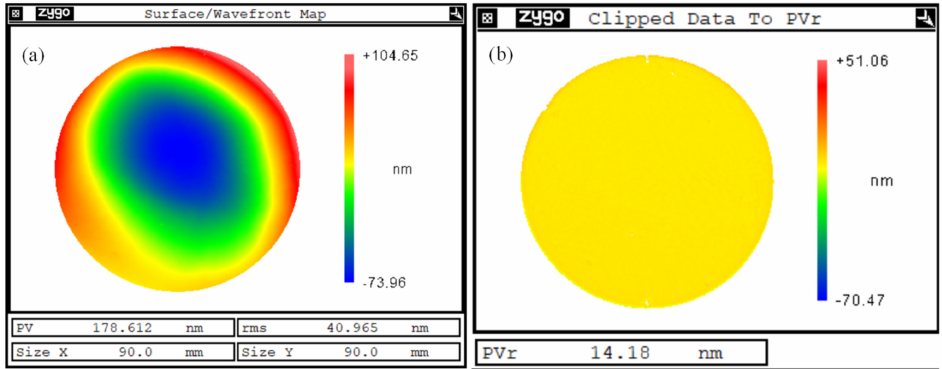
Figure 7. A typical surface figure that can be figured to sub − nanometer precision: initial surface figure ( a ), and the filtered surface figure component with f c = 0.2 mm − 1 ( b